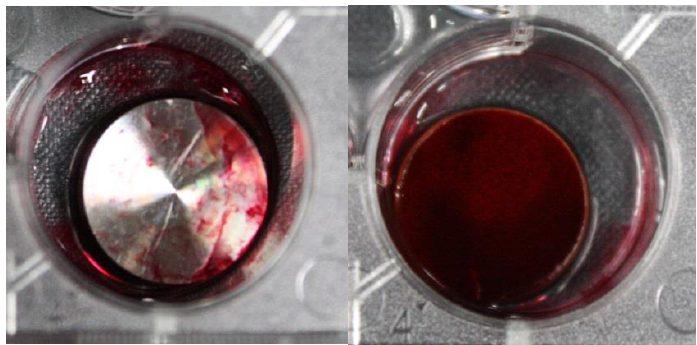
Figure 10. Levels of calcification on the surfaces of plates: bone calcification on the untreated titanium plate ( left ) and on the titanium plate treated with amine plasma ( right ).